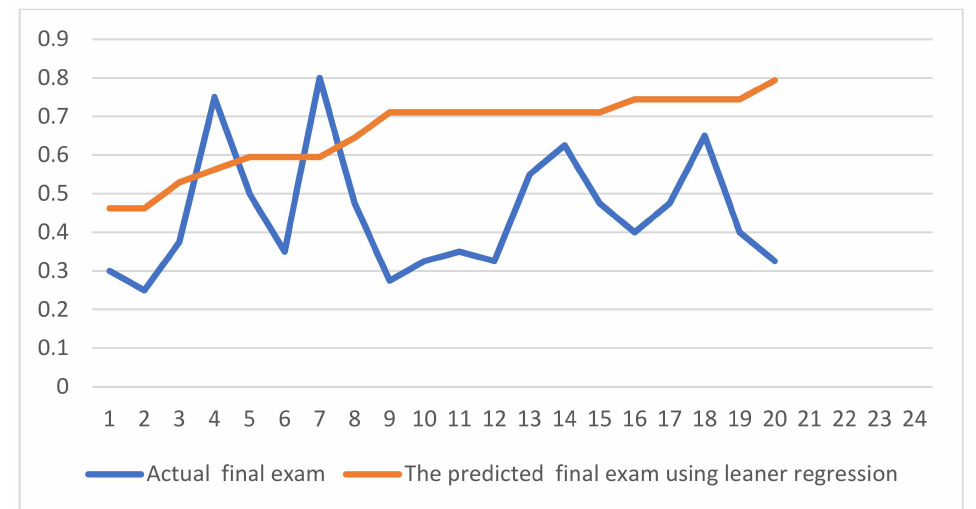
Figure 9. Linear regression model